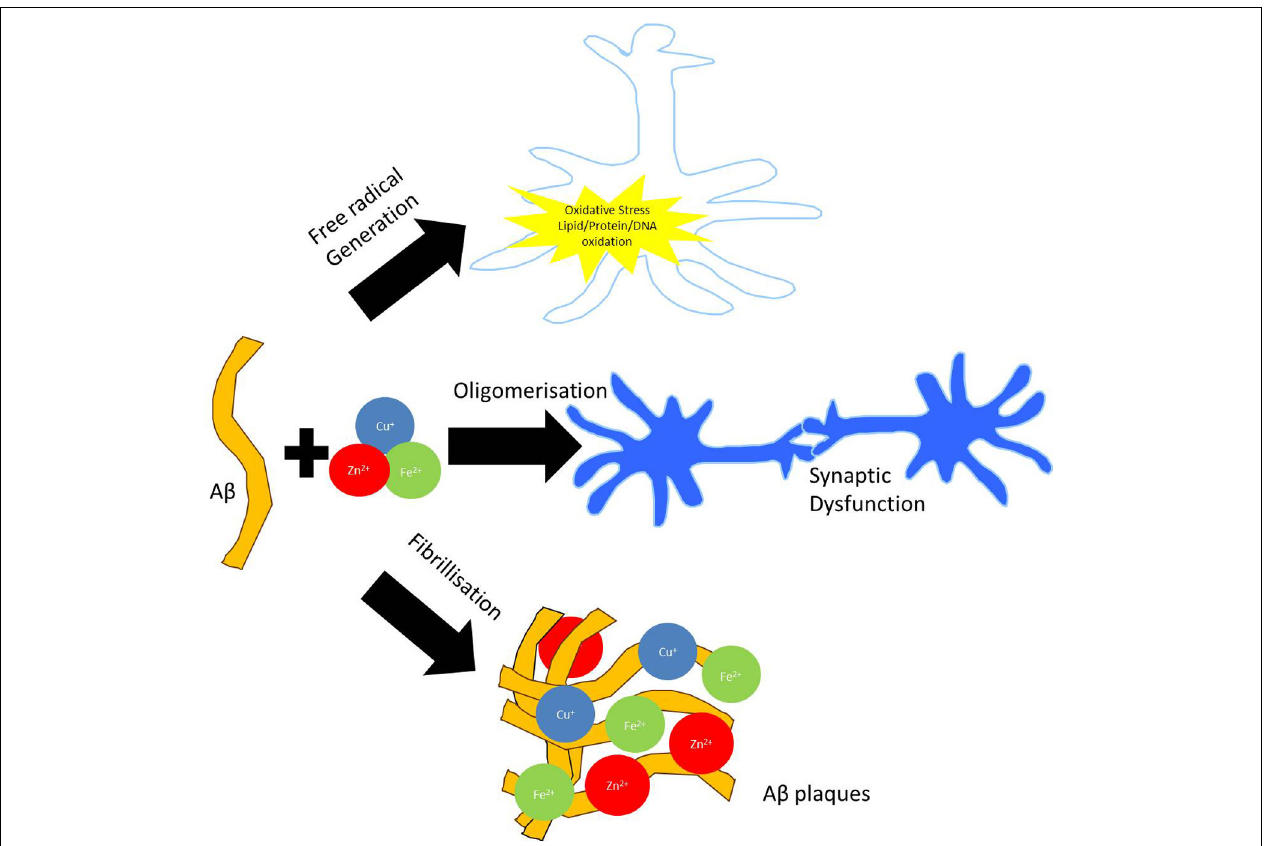
FIGURE 1 | Involvement of metal dyshomeostasis in AD pathology. Aggregation of A β can bind redox active metals such as copper, iron, and zinc in amyloid plaques. Sequestration of these biometals on A β fibrils and oligomers can potentiate synaptic dysfunction. Redox cycling of Cu 2 + /Cu + and Fe 3 + /Fe 2 + in the amyloid plaques